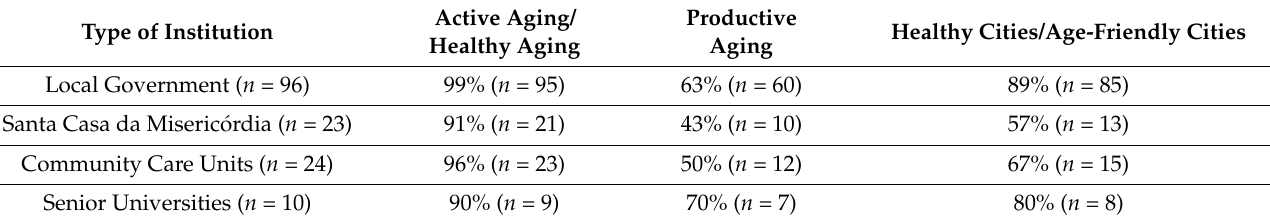
Table 2. Knowledge of the actors for some key concepts of